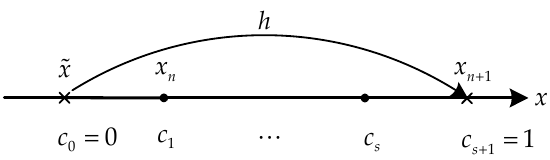
Figure 2. Schematic diagram of the grid points for generalized Adams methods (GAMs).